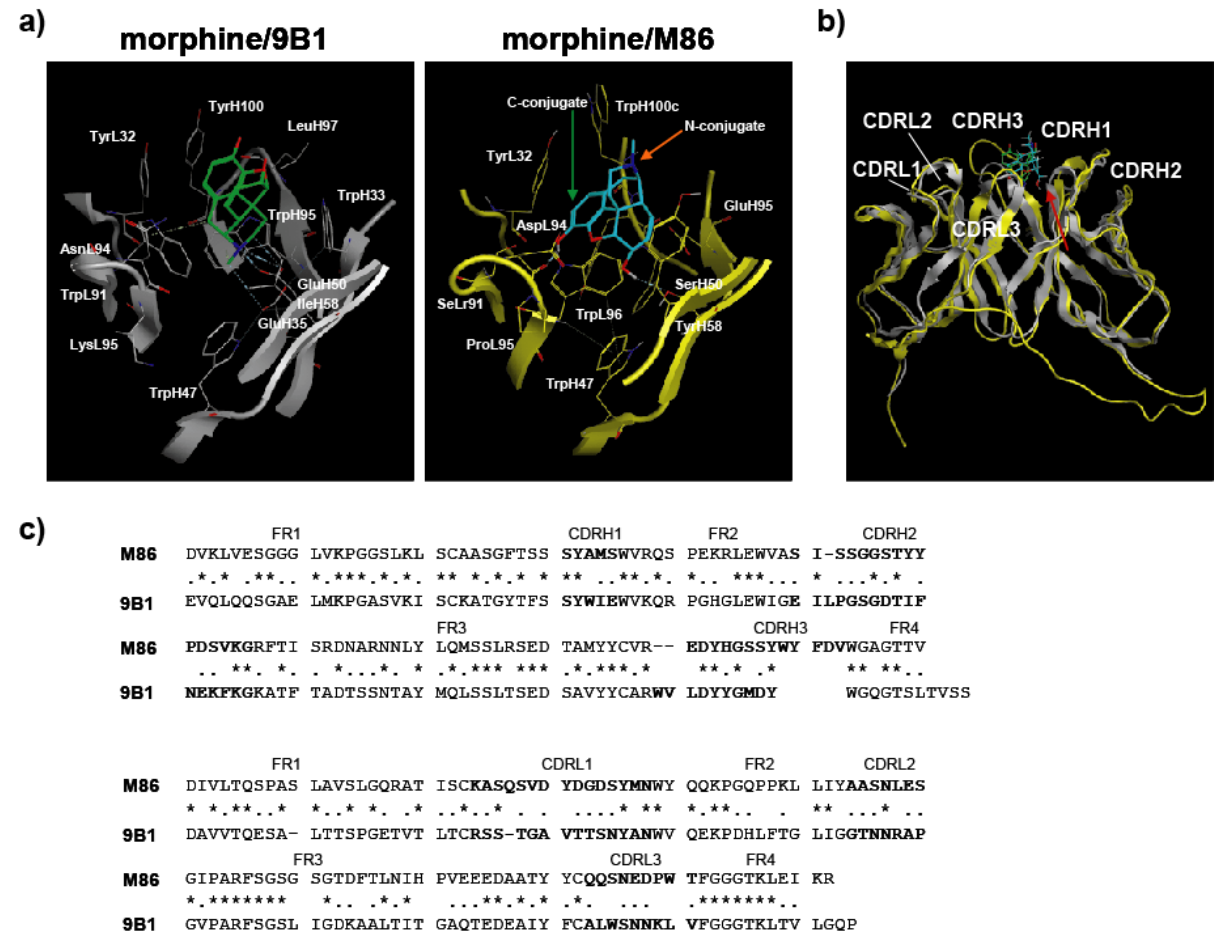
Figure 8. Computer simulations for the structure of M86 scFv. ( a ) Side view of the ligand interaction surface of 9B1 and M86. ( b ) Superposition of M86 with 9B1. The red arrow indicates the direction of the side view in ( a ). (c) Amino acid sequences of 9B1 and M86. Asterisks and dots indicate identical residues and similar residues,